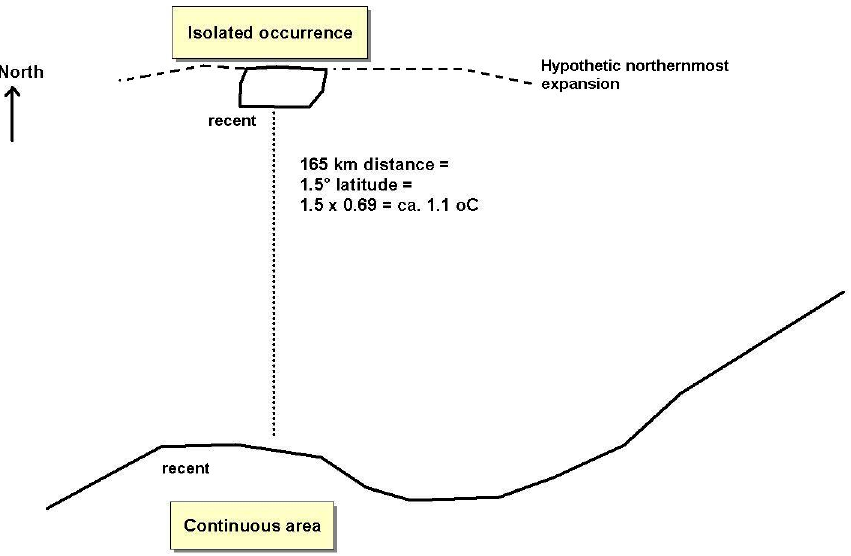
Figure 1. Disjunction between an isolated poleward population and the indicated former climatic optimum, in the case of a gap of North-South distance (N-SD) = 165 km.